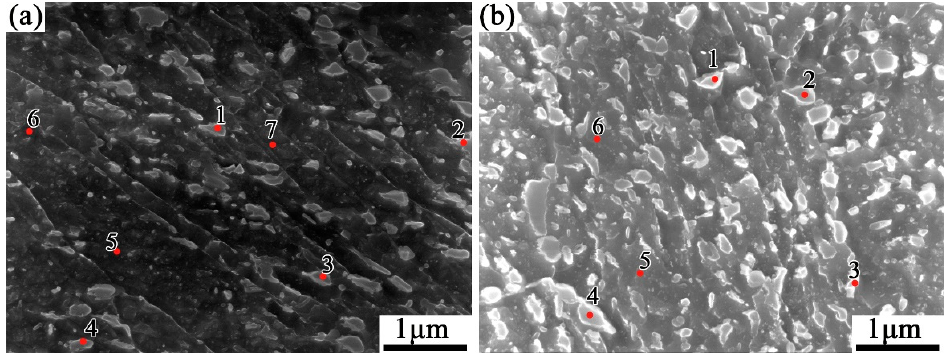
Figure 9. SEM images of the normal ( a ) and banded ( b ) areas of QT1 sample.